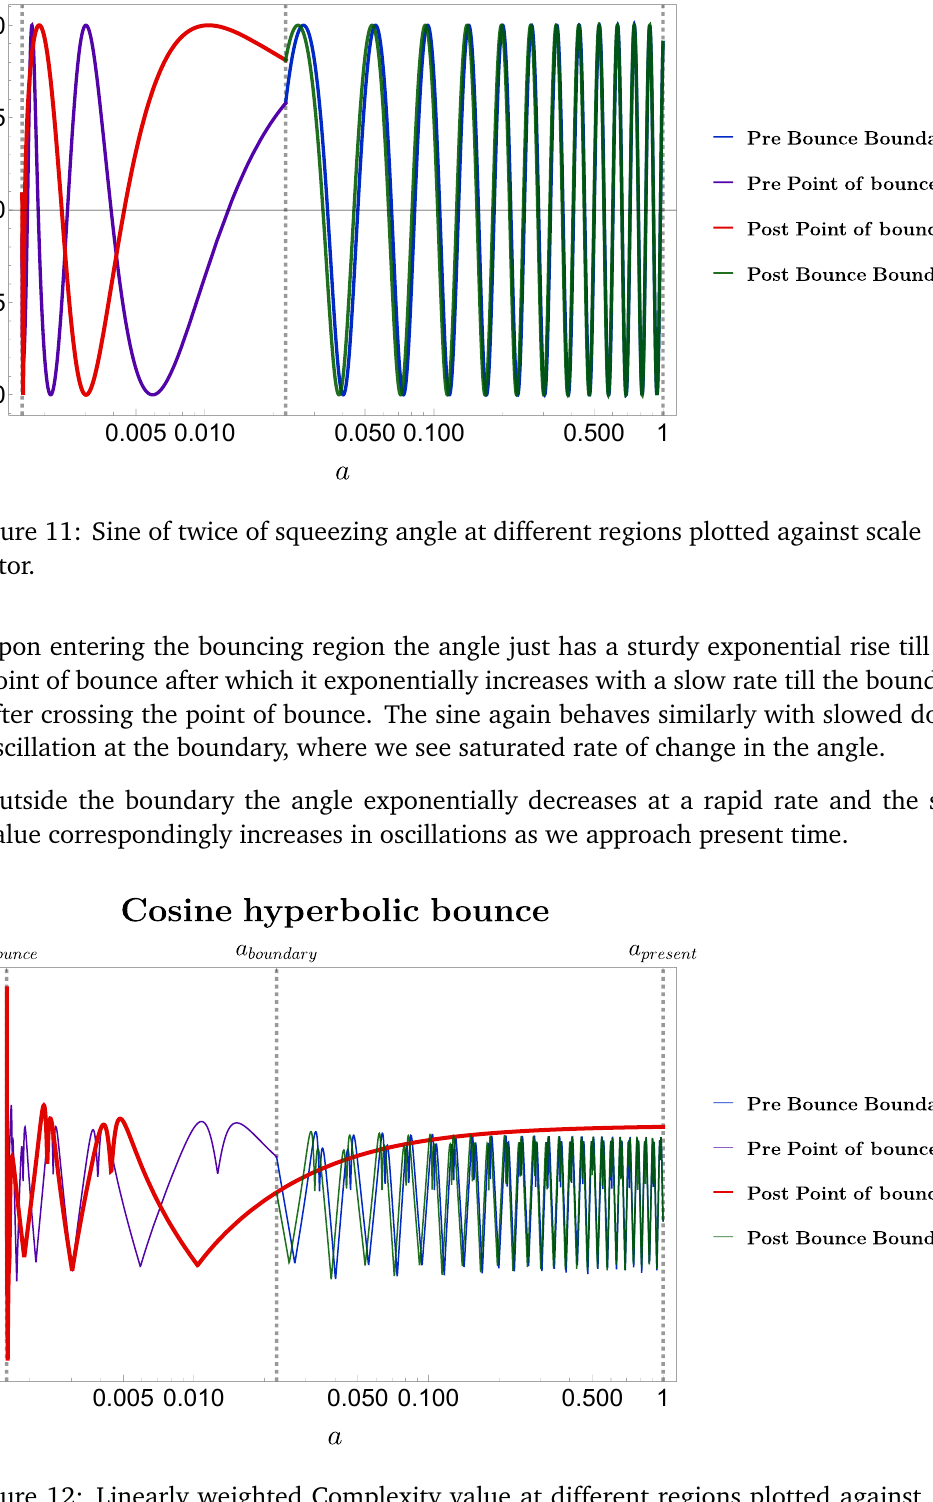
Figure 12: Linearly weighted Complexity value at different regions plotted against scale